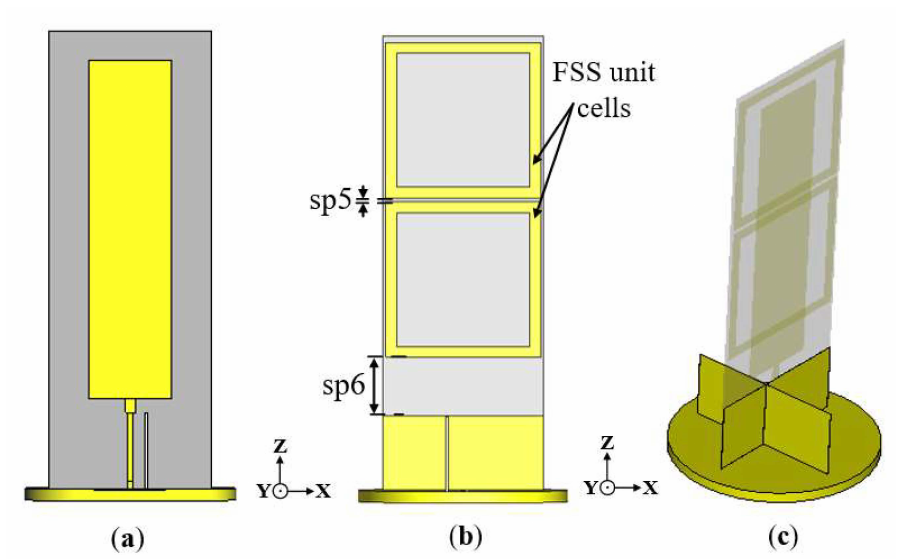
Figure 6. Geometry of proposed antenna with both cross-ground structure and FSS unit cells: ( a ) front view, ( b ) back view showing FSS unit cells, and ( c ) side view.